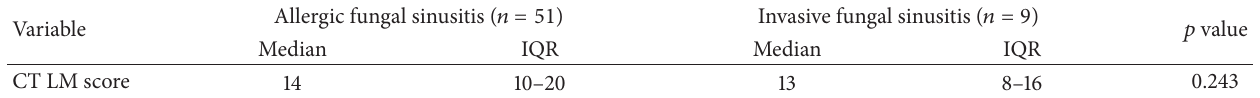
Table 8: Lund-Mackay